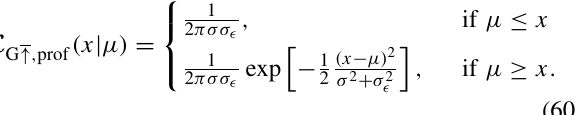
Fig. 6 The different generic likelihood functions available in GAM- BIT , described in Sect. 8.3: Gaussian ( top left ), Gaussian limit ( top right ) and log-normal ( bottom ). Here we show the log-normal likeli- hood computed with a fixed absolute systematic uncertainty ( bottom left ), and instead with a fixed fractional (relative) systematic uncer- tainty ( bottom right ). Each curve is computed assuming an observed